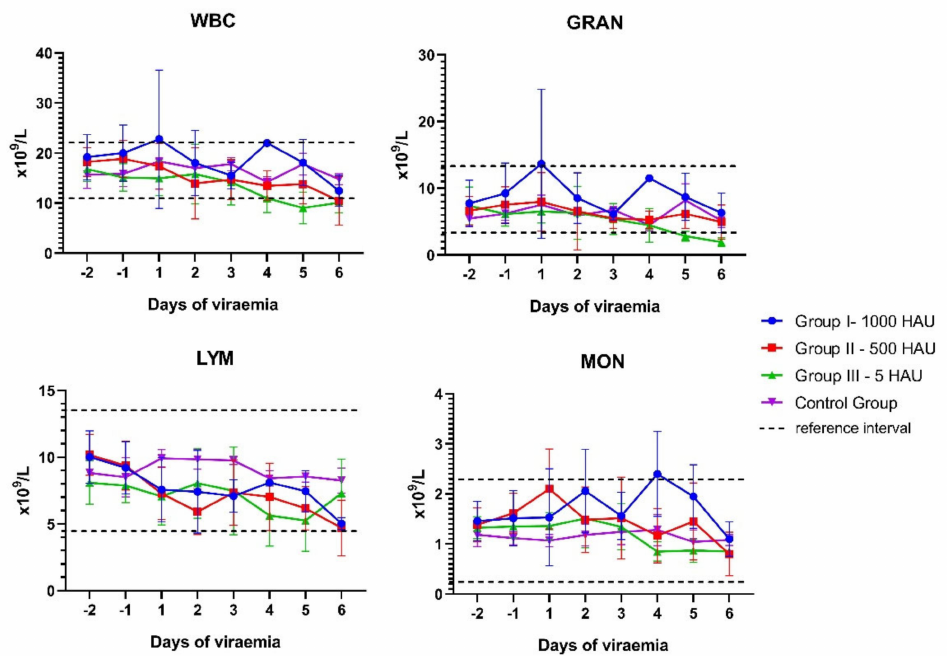
Figure 1. Mean values of white blood cell counts observed during the infection. WBC – white blood cells; GRAN – granulocytes; LYM – lymphocytes; MON – monocytes. Error bars indicate standard